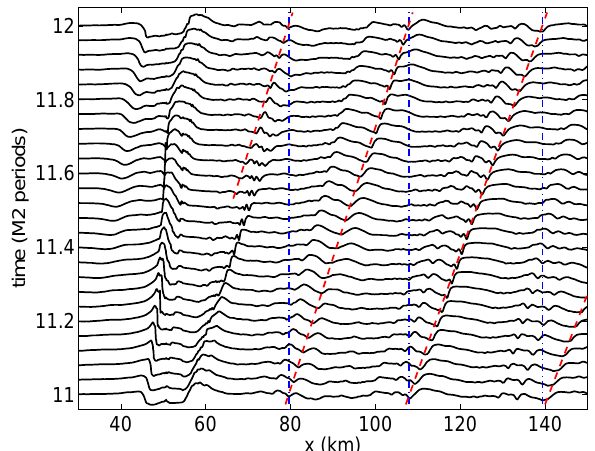
Fig. 4. In E2, vertical displacement of the isopycnal where N(z) is maximal between 11 and 12 M2 periods after the start of the simu- lation. Two isopycnals on the left side of the pictures are separated by 1 / 25 M2 periods, also corresponding to 30m in terms of dis- placement amplitude. Red, dashed lines follow four different wave trains at different locations, each of them having been generated one M2 period after the other. The blue, dash-dotted lines help noticing that the four leading deformations highlighted by the red, dashed lines can be seen as four different life stages of a single wave train. The large displacement located between 40 and 60km corresponds to the ITB impact on the